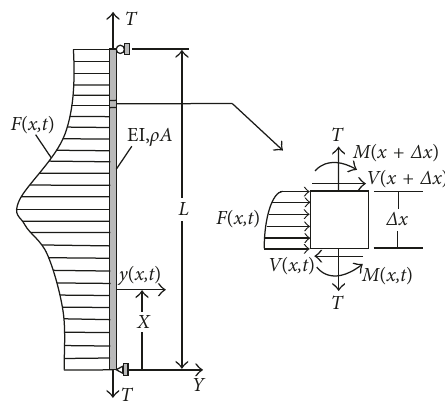
Figure 2: Analytic dynamic model of a suspender